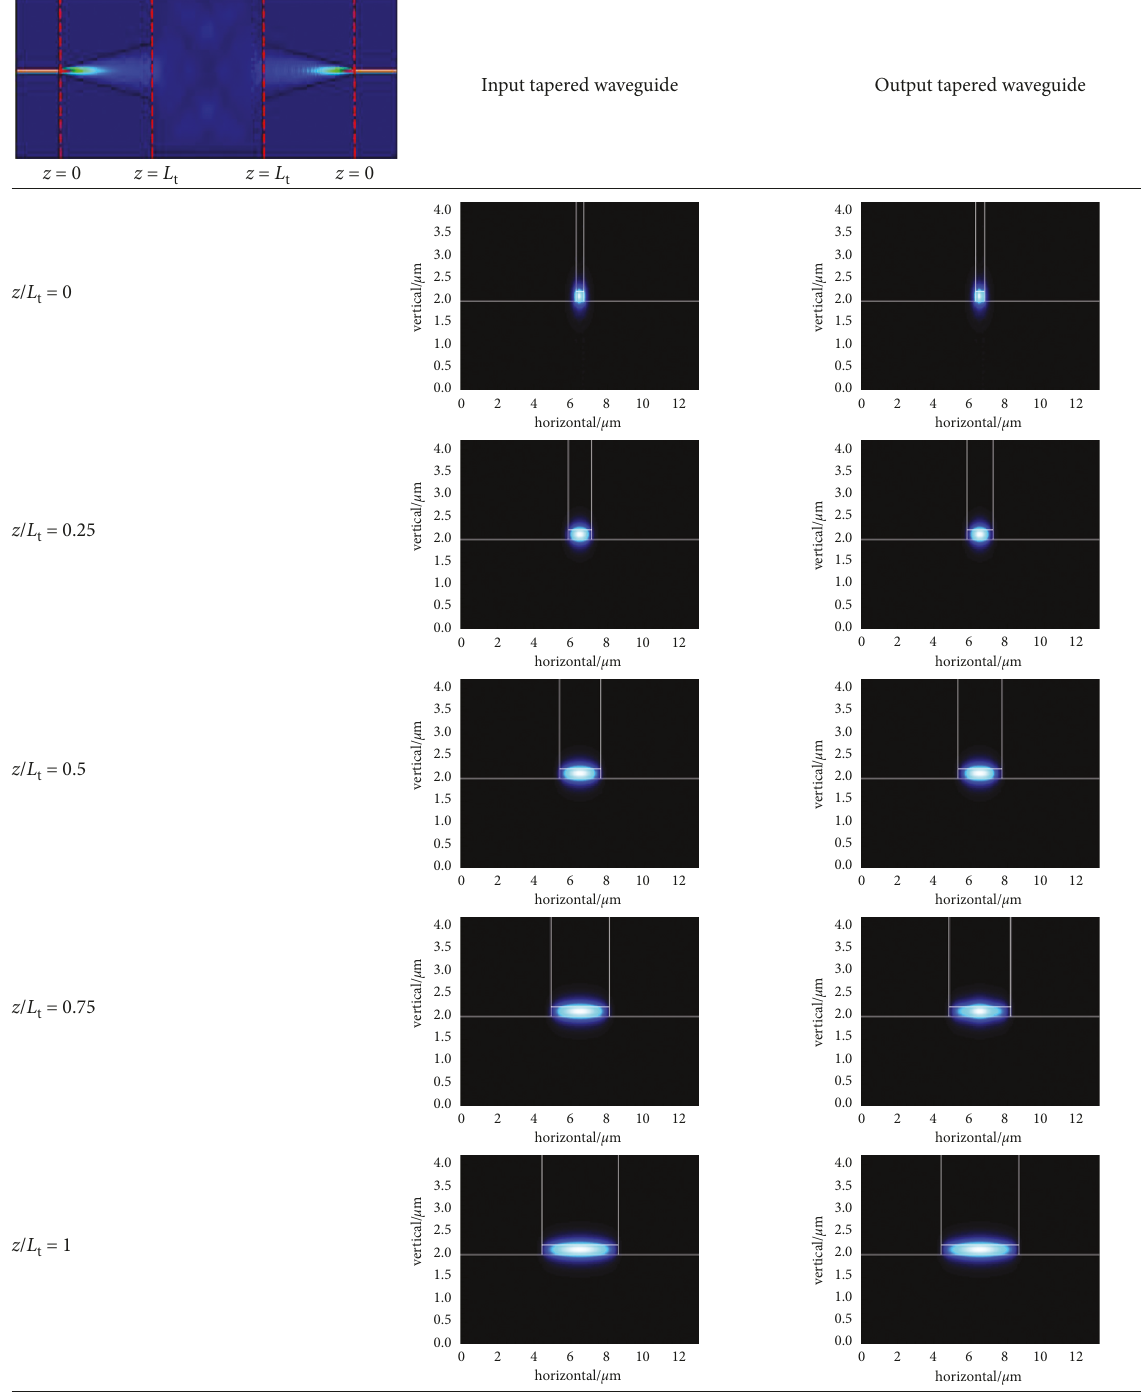
Figure 7: A 1 × 1 MMI in width of 12 μ m and in length of 257.2 μ m is combined with the linear tapered waveguide in width W in length L t of 217.7 μ m. When the location of input/output linear tapered waveguide is z/ L t of 0/0.25/0.5/0.75/1, the fundamental mode TE 0 shape of input/output port is simulated to change the mode shape size from small to larger mode shape under TE 0 adiabatic mode